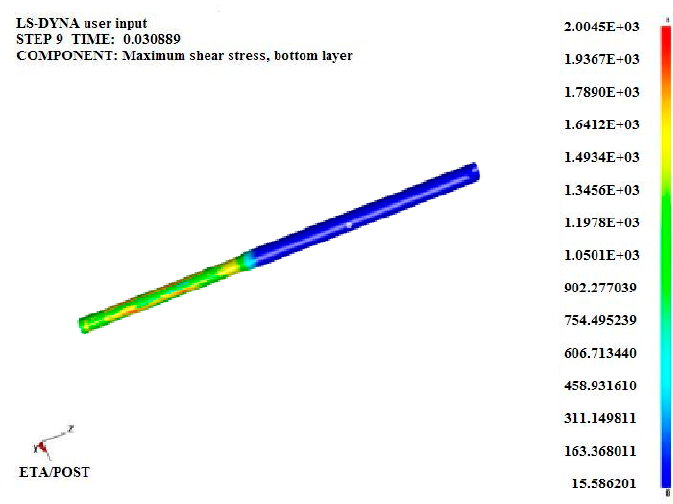
Figure 18. Stress in the formed material after the eleventh draw σ = 1 936 MPa. Metals 2019 , 9 , x FOR PEER REVIEW 16 of 20